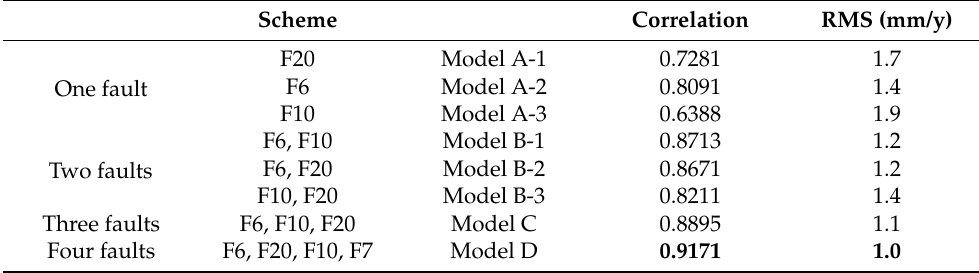
Table 3. The correlation between the InSAR observation and its associated predictions.